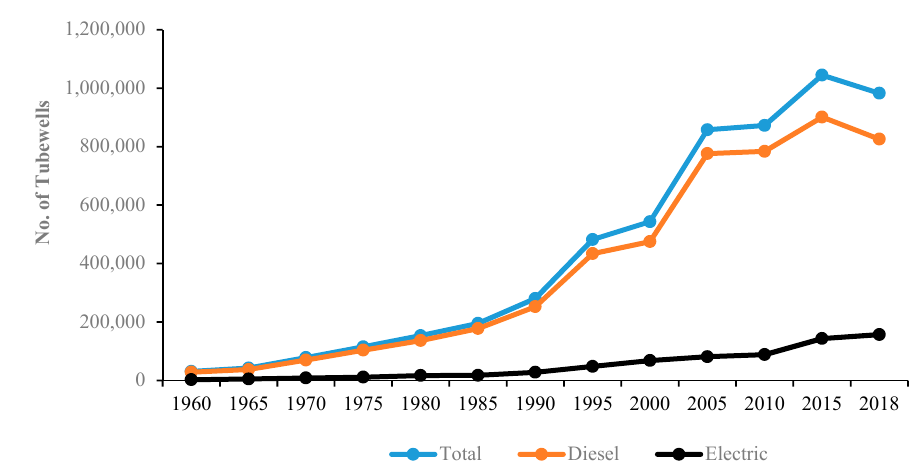
Figure 2. Temporal development of private tubewells in the Punjab province of Pakistan (Source: Punjab Agricultural Statistical Department).